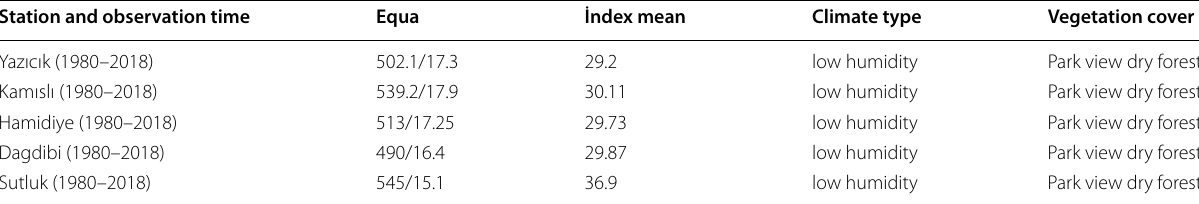
Table 8 Index values according to the Erinç index Station and observation